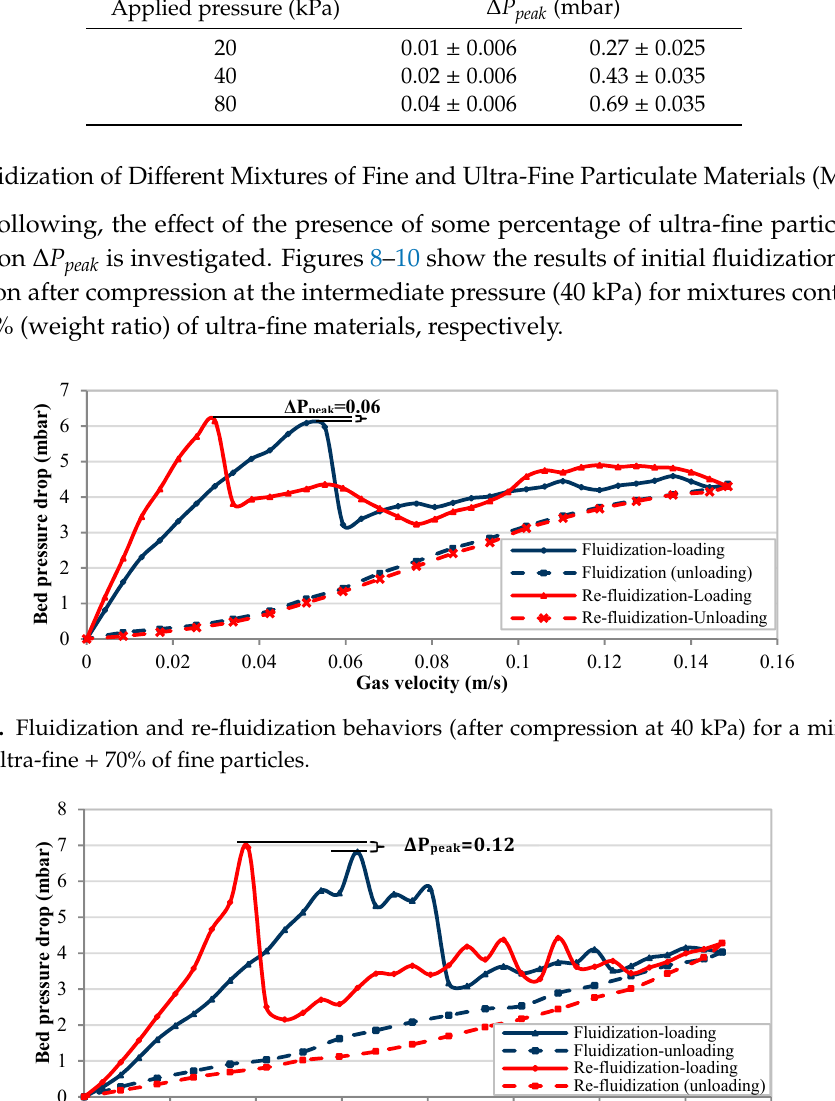
Figure 10. Fluidization and re-fluidization behaviors (after compression at 40 kPa) for a mixture of 68% of ultra-fine + 32% of fine particles. The results of increasing the peak of bed pressure drop (in the loading process) due to applying the other sets of compression pressures are summarized in Table 7. As can be seen from Table 7, when increasing the portion of ultra-fine particles, Δ𝑃 (cid:3043)(cid:3032)(cid:3028)(cid:3038) increases monotonously; the lowest value of Δ𝑃 (cid:3043)(cid:3032)(cid:3028)(cid:3038) is always related to the pure fine particles, the highest one to the pure ultra-fine powder (Table 6).